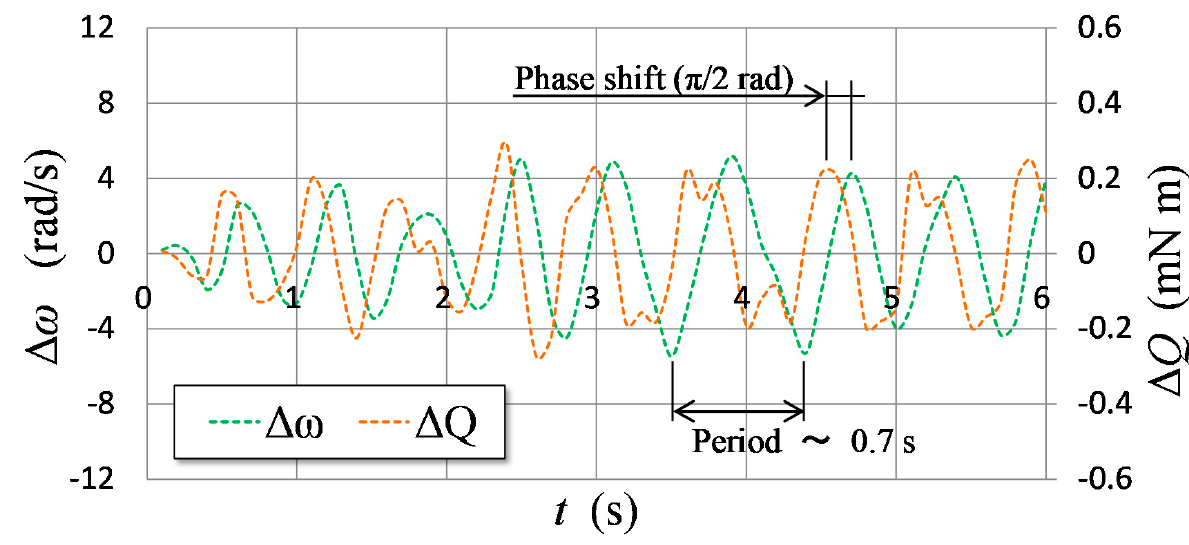
Figure 18. Phase shift between difference in angular velocities and that in torques, of two rotors in phase synchronization for CD layout with gap / D = 0.2 (data do not correspond to Figure 17 but Figures 8b and 9b).